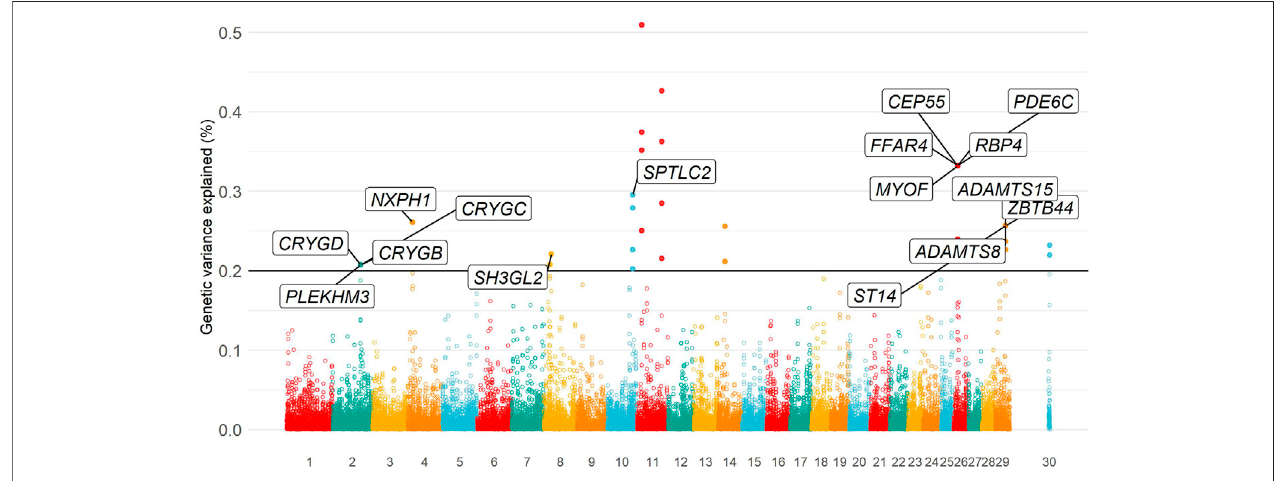
FIGURE 3 | Manhattan plot of additive genetic variance explained by genomic windows for yearling temperament using the D model.